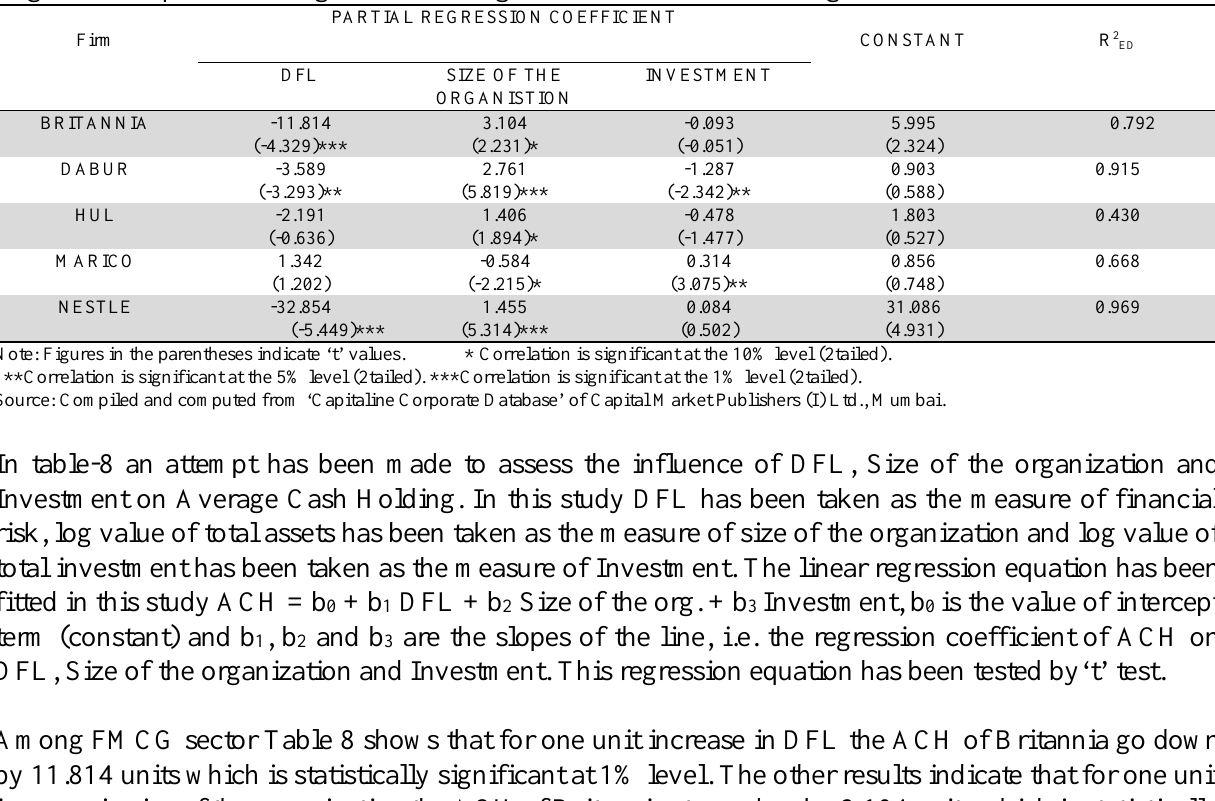
Analysis of Multiple Regression of Avg. Cash Holding on DFL, Size of Org. and Investment of the Selected Companies of FMCG